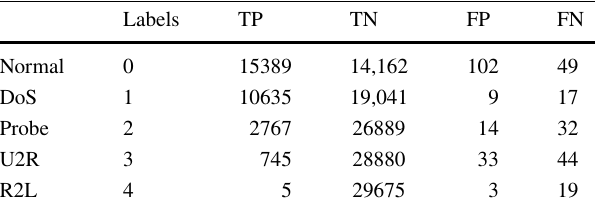
Table 13 Rate of attacks after feature selection